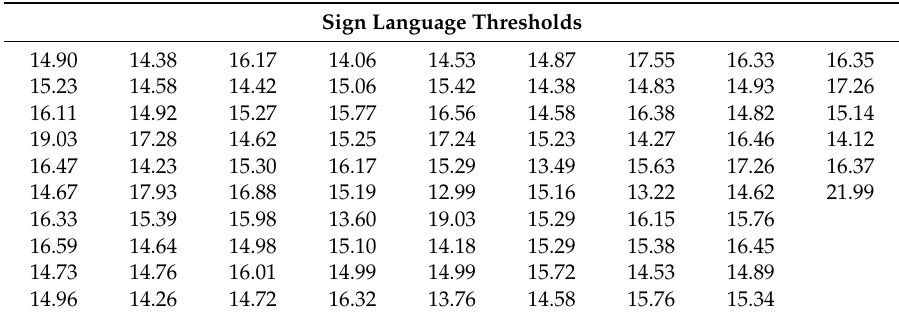
Table 4. Sign language thresholds. Thresholds for each location in the table correspond to the location in Table 1.